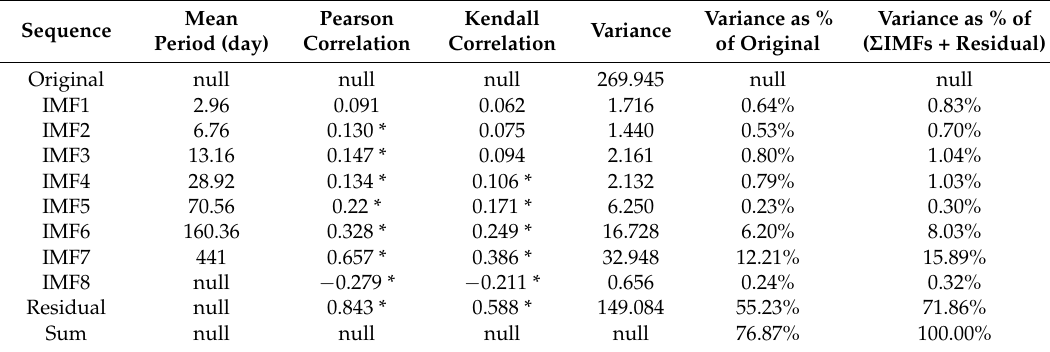
Table 4. Measures of the intrinsic mode functions (IMFs) and the residual.